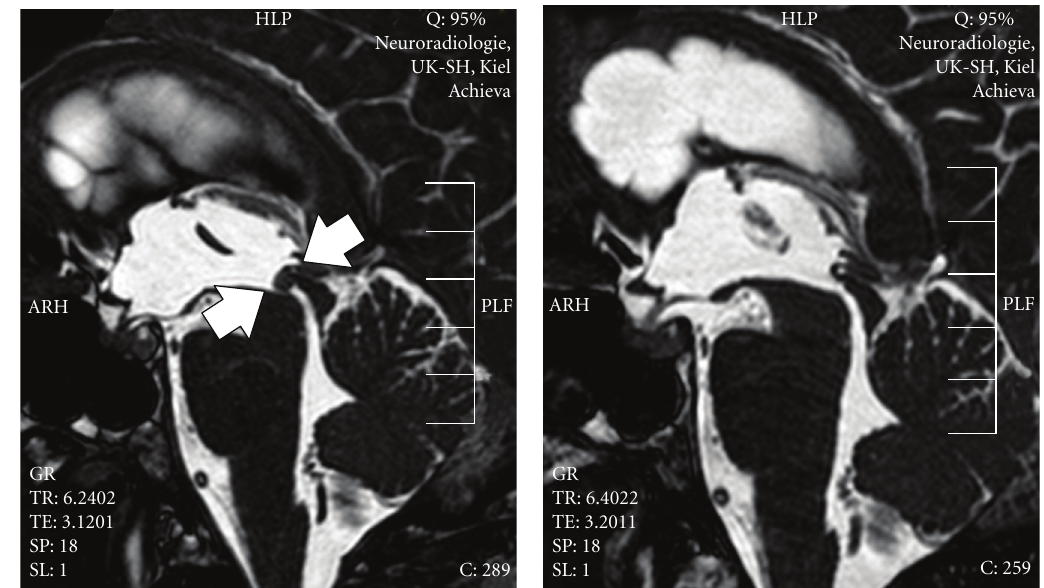
Figure 2: T2-weighted sagittal MRI (left) before and (right) after endoscopic tumor removal with restoration of the aqueduct. The tumor is marked by arrows.